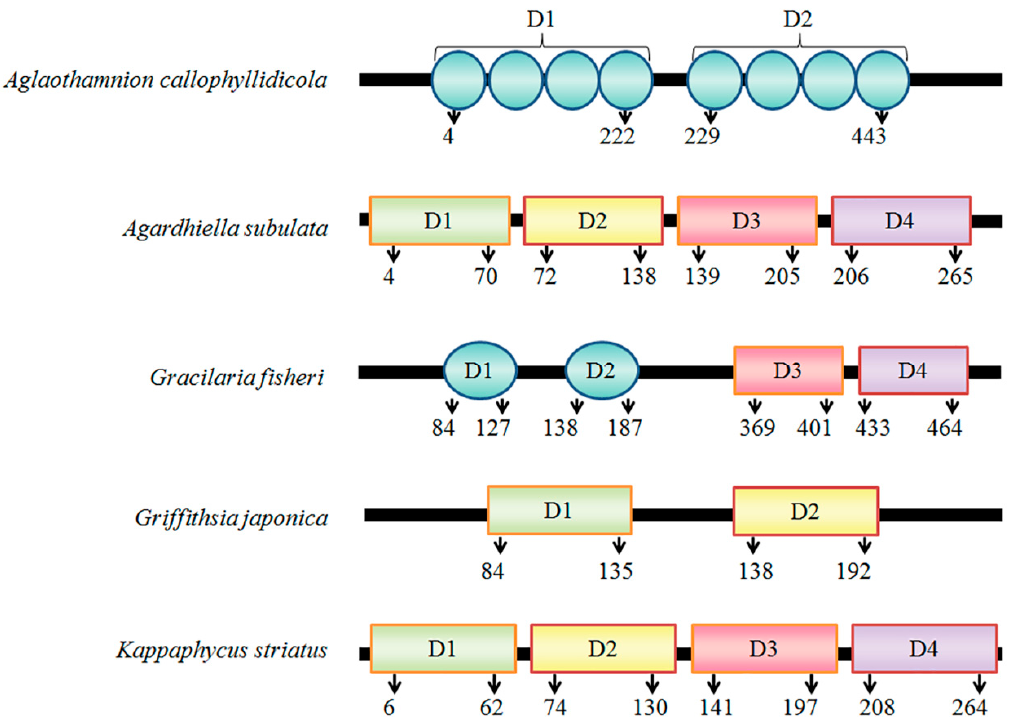
Figure 1. Primary structure of red algal lectins with a tandem repeat structure. The sequences were obtained from NCBI GenBank under the following accession numbers: A. callophyllidicola (from Shim et al. [18]), A. subulata lectin (ASL-1, BAX08598), G. fisheri or H. fisheri lectin (ACY56710), G. japonica